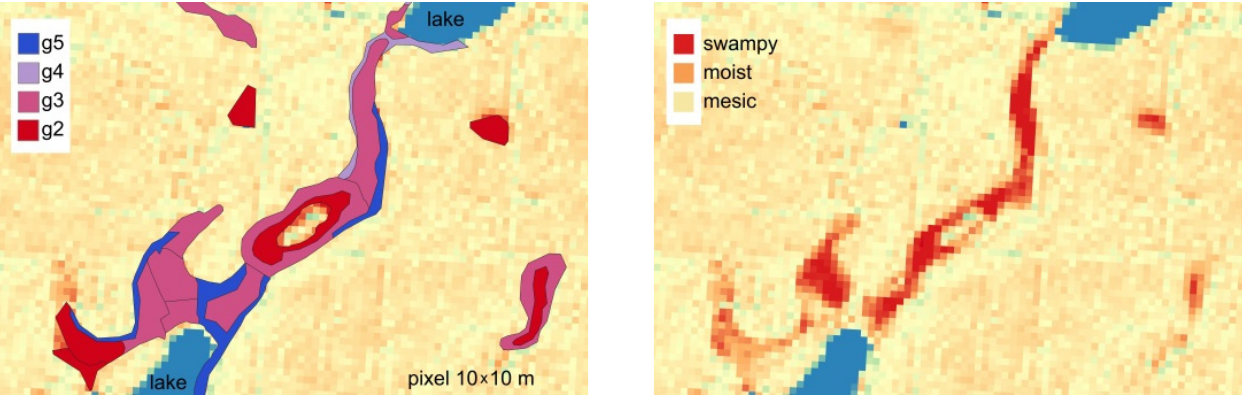
Figure 7. Comparison of the image of a fragment of the habitat map made with the traditional method of soil pits on the background of NDVI map ( left ) with the image of the same area differentiated due to the NDVI values ( right ). Only g2–g5 FHMIs are included in the image legend on the left. The main background of the picture shows the g6 FHMI. The g1 and g7 FHMIs do not exist in the presented part of area .